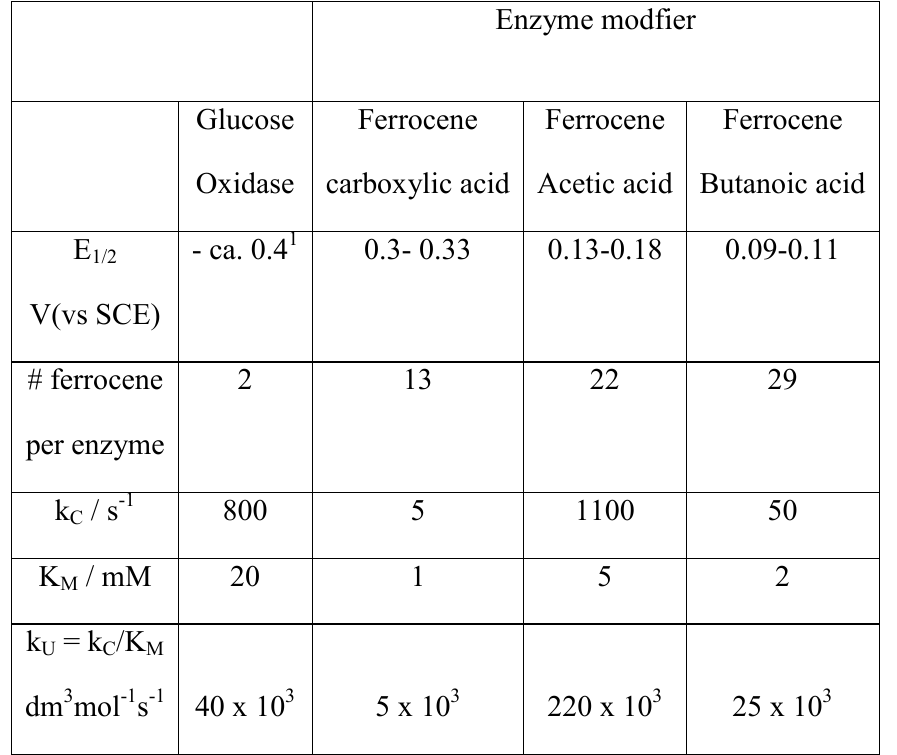
Table 1. Experimental data (reference 13) obtained for electro-enzyme direct